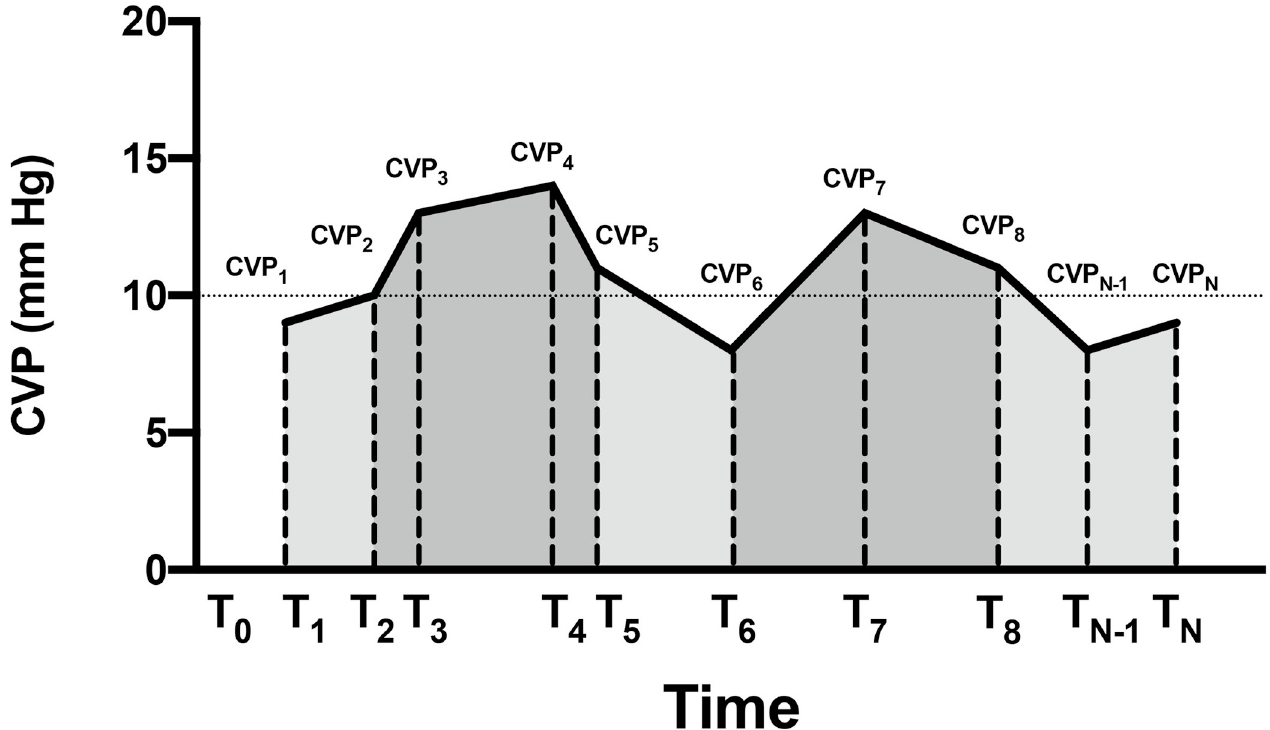
Fig 1. Diagram of the calculation of central venous pressure loads. T 0 is the time of ICU admission, and T N is the time of the last CVP measurement within the first 72 hours of ICU stay. Central venous pressure (CVP) load is calculated as the area under the CVP curve, which equals to (CVP 2 + CVP 1 )/2 × (T 2 –T 1 ) + (CVP 3 + CVP 2 )/2 × (T 3 –T 2 ) + ... + (CVP N + CVP N-1 )/2 × (T N − T N-1 ). CVP duration is the total time of CVP monitoring, which equals to (T N − T 1 ). Normalized CVP load is thus CVP load divided by CVP duration. Elevated CVP (ECVP) is defined as the average CVP level of two adjacent time points > 10 mmHg, and the ECVP load is defined as the sum of ECVP areas (areas in dark gray). ECVP duration is the sum of the corresponding time interval of ECVP (i.e., (T 2 –T 1 ) + (T 6 –T 5 ) + (T N − T 8 ) in the diagram). Normalized ECVP load is thus ECVP load divided by ECVP